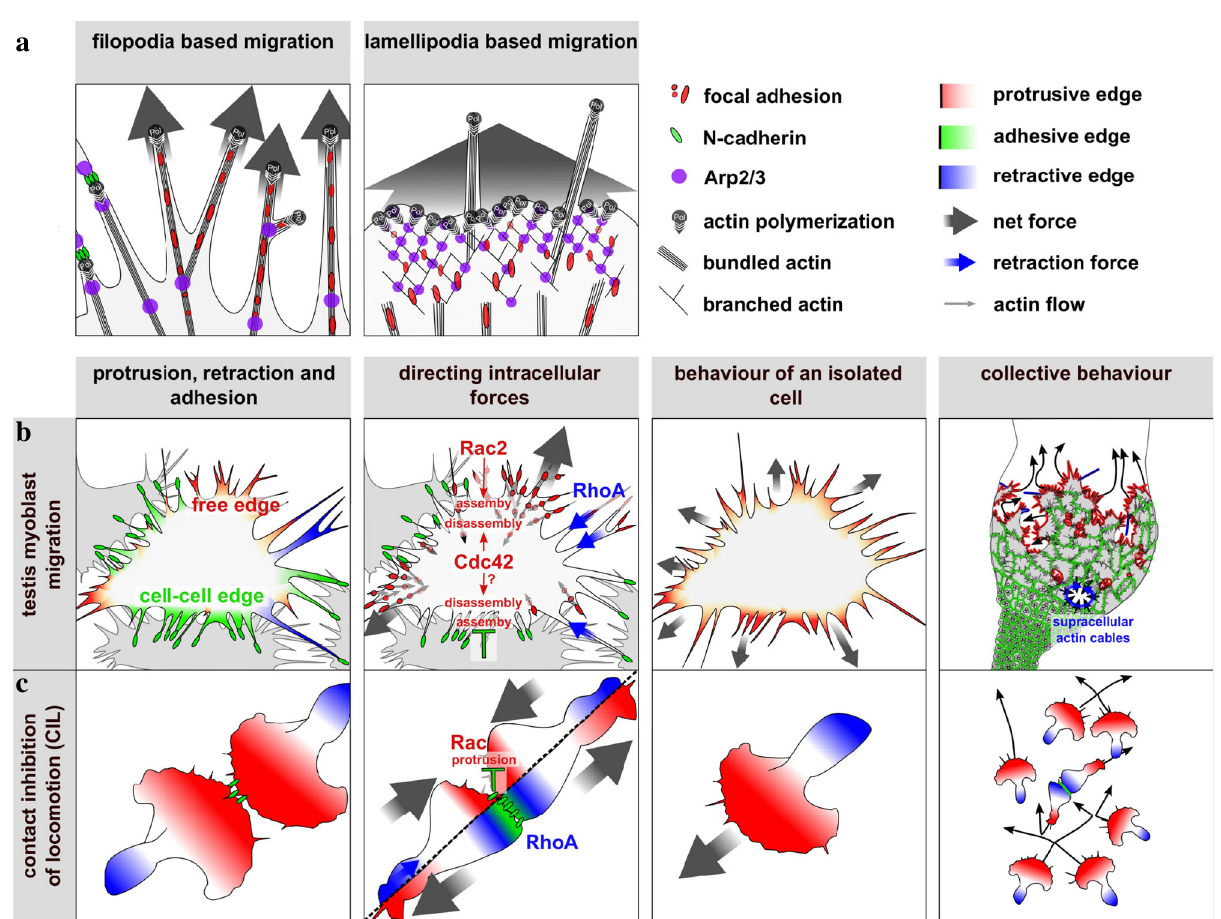
Fig. 8 Proposed model. a Comparison between fi lopodia-based and lamellipodia-based cell migration. Lamellipodia-based migration requires the Arp2/3 complex generating branched actin fi lament networks that serve as the major engine to push the leading edge forward, whereas fi lopodia support mesenchymal migration by promoting cell – matrix adhesiveness at the leading edge stabilizing the advancing lamellipodium or by sensing the environment. In fi lopodia-based migration, it seems that fi lopodia replace the lamellipodium as the motor of motility. We assume that polymerization of bundled actin fi laments through formins pushes parts of the membrane. Arp2/3 complex contributes to fi lopodia branching and thereby provides new barbed ends generating new fi lopodia. b Key features and cell behavior in testis myotube migration compared to c migrating mesenchymal neural crest cells undergoing CIL. Different from neural crest cells, myotubes did not migrate as loose cohorts, but maintain cohesiveness. Unlike neural crest cells, migrating myotubes are not simply polarized along a front-rear axis and do not form a contact-dependent intracellular Rho gradient that initiates cell polarization driving directed cell migration. In myotube migration, a contact-dependent asymmetry of cell – matrix adhesion rather acts as a major switch to drive locomotion toward the free space. Individually or loosely connected migrating cells, like neural crests cells are able to migrate persistently due to classical front-rear polarity. By contrast, testis myotubes rely on constant cohesion to break symmetry. Supracellular contractile actin cables contribute to the integrity of the migrating cell cluster and thereby to